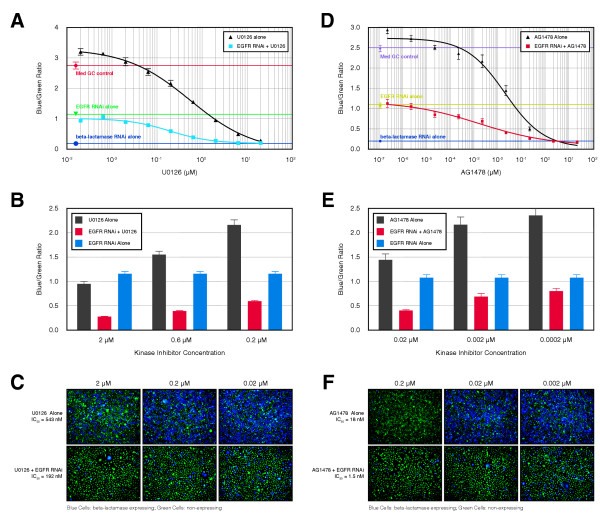
Combining RNAi toward EGFR and the kinase inhibitors U0126 and AG1478 increases the potency of the small molecule compounds. Small molecule kinase inhibitors shown to have inhibitory properties in the AP-1 CellSensor assay were used in tandem with RNAi. RNAi targeting the EGFR was kept constant while U0126 targeting MEK-1 kinase (Panel A) and AG1478 targeting EGFR (Panel C) were used in a dose response manner to examine potency effects of the combined treatment. The shift in IC50 indicates the "cocktail" effect seen with the tandem treatment.